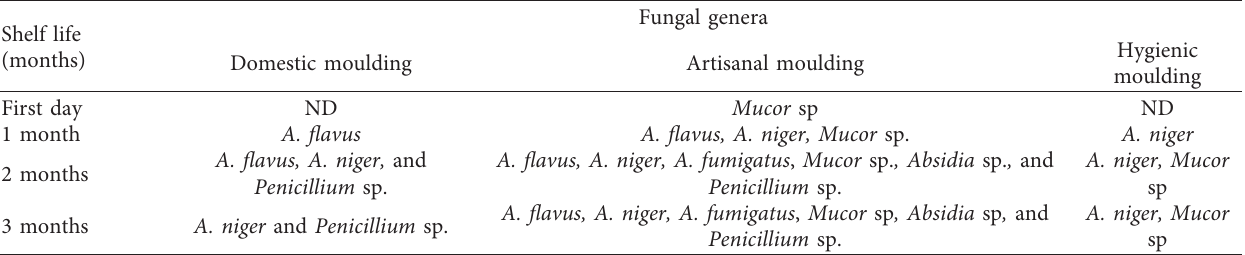
Table 3: Evolution of fungal contaminants identified in peanut paste samples during storage according to the type of moulding.